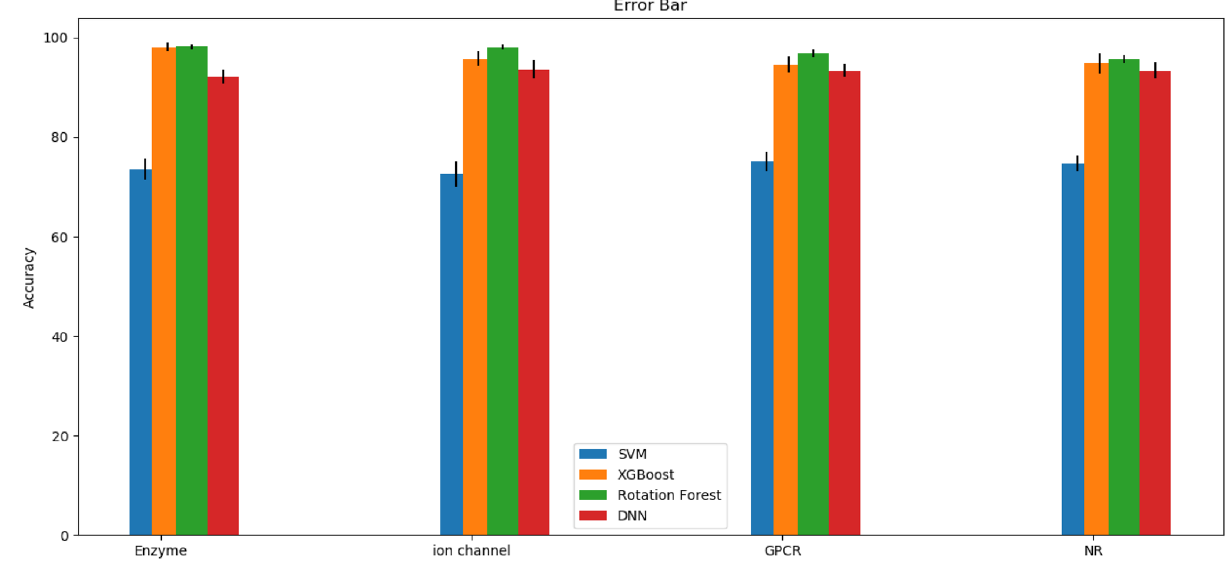
Figure 5. Studying classification models based on error bars for underlying datasets.